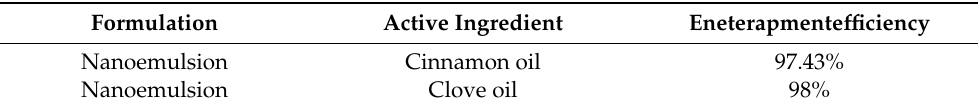
Table 13. Encapsulation efficiency of optimized nanoemulsion.